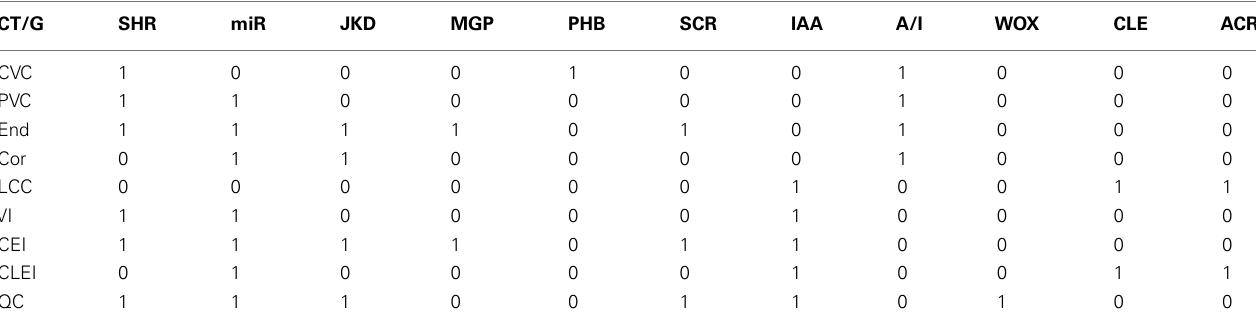
Table 3 | Expected attractors.